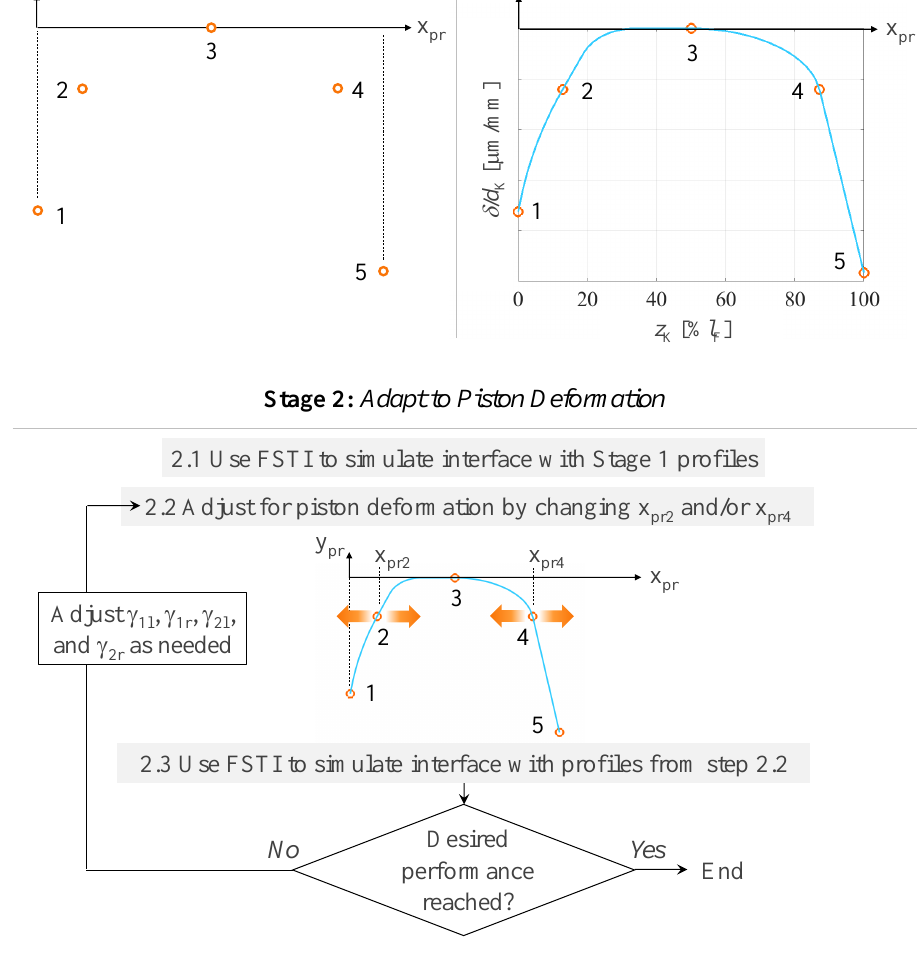
Figure 9. Overview of the